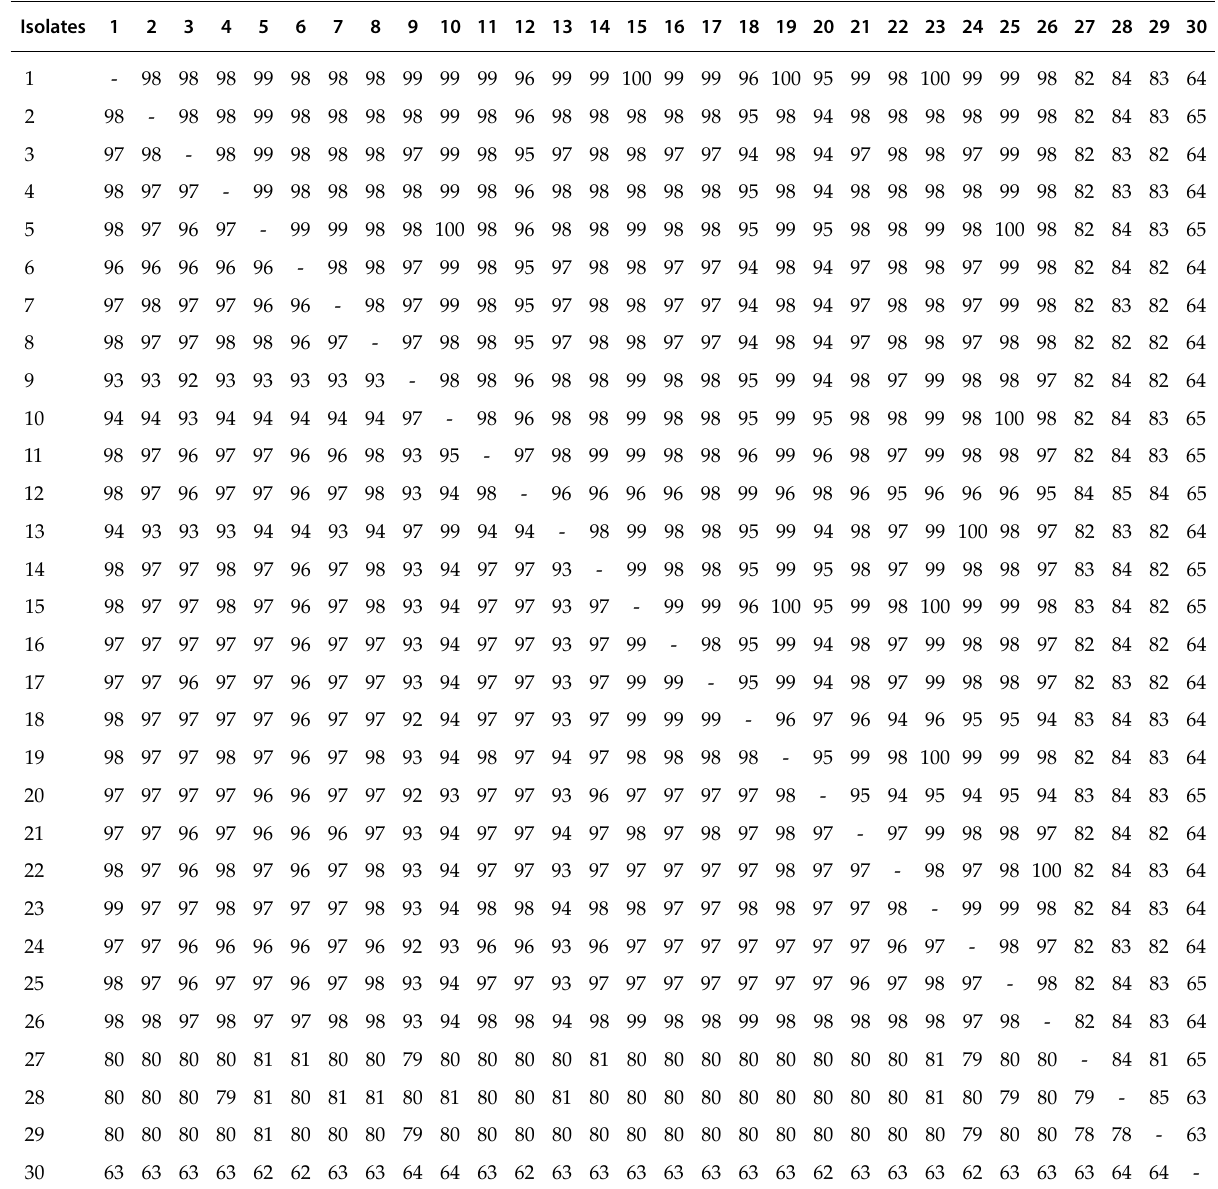
Table 3. Per cent homology of nucleotides (below diagonally) and amino acids (above diagonally) of the GBNV isolates and the other tospoviruses of the WSMoV